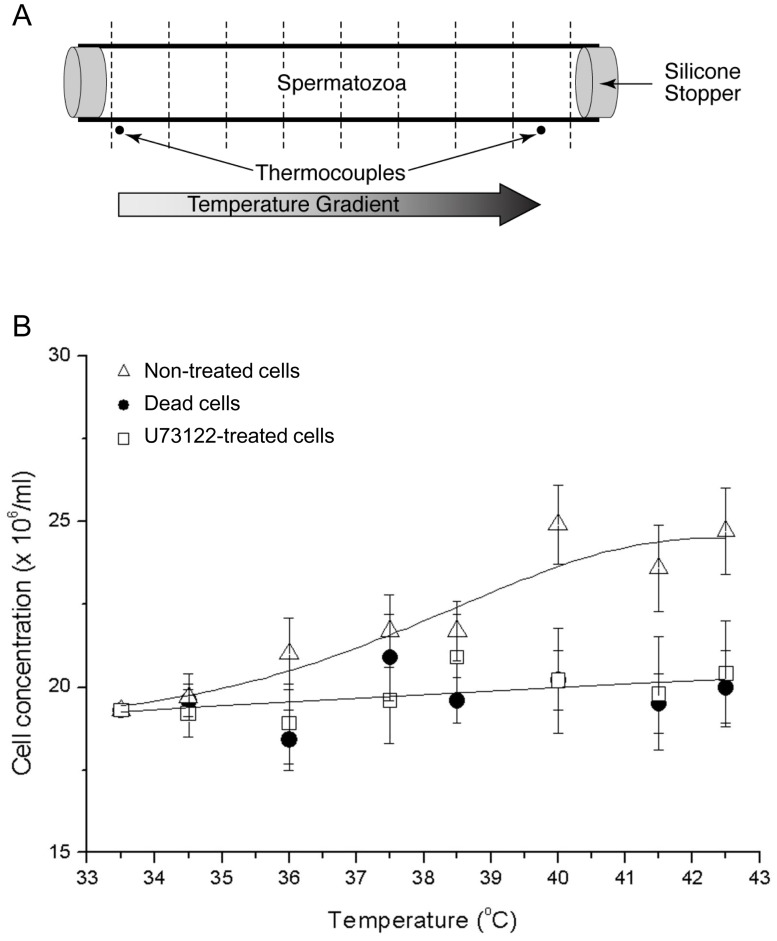
Human sperm distribution in a linear temperature gradient.
A: Schematic illustration of the drinking straw, fitted to the dimensions of the thermoseparation device, and used to measure the sperm distribution in a linear temperature gradient. The straw, homogeneously filled with human spermatozoa at the commencement of a measurement, was frozen in liquid nitrogen at the end of the measurement and cut into 8 equal parts at the locations marked by dashed lines. B: Temperature preferences of human spermatozoa. The temperatures shown in the abscissa were measured inside the straw. The number of spermatozoa in the straw’s outermost segment (the warmer side) could not be counted due to loss of volume (since this was the segment cut last). For this reason the highest temperature shown in the figure is 41.7°C rather than 42.3°C. The results with the inhibitor U73122 were corrected for the solvent (ethanol) effect by subtracting the difference between ethanol and untreated cells (control) from the values obtained with U73122 at each temperature tested. Both the results (mean ± SEM) of untreated cells (9 experiments, 20 measurements in total) and the results of cells treated with U73122 (7 experiments, 13 measurements) were normalized according to the results of dead cells (4 experiments, 12 measurements) at 36.8°C. Sperm accumulation of untreated cells at 40.4°C, 41.2°C and 41.7°C was significantly higher than sperm accumulation at 36.8°C, 38.1°C, 38.5°C, 38.9°C and 39.7°C (P<0.0001, according to the contrast t-test). The connecting line is a hypothetical sigmoidal-curve fit (R2 = 0.91; Origin 6.1 software, OriginLab). The differences between the untreated cells and the negative controls (dead and U73122-treated cells) were statistically significant only at temperature values ≥40°C (Marked with Asterisks; P≤0.04, according to the one-way ANOVA). The straight line was calculated according to the average of the negative controls at each tested temperature.